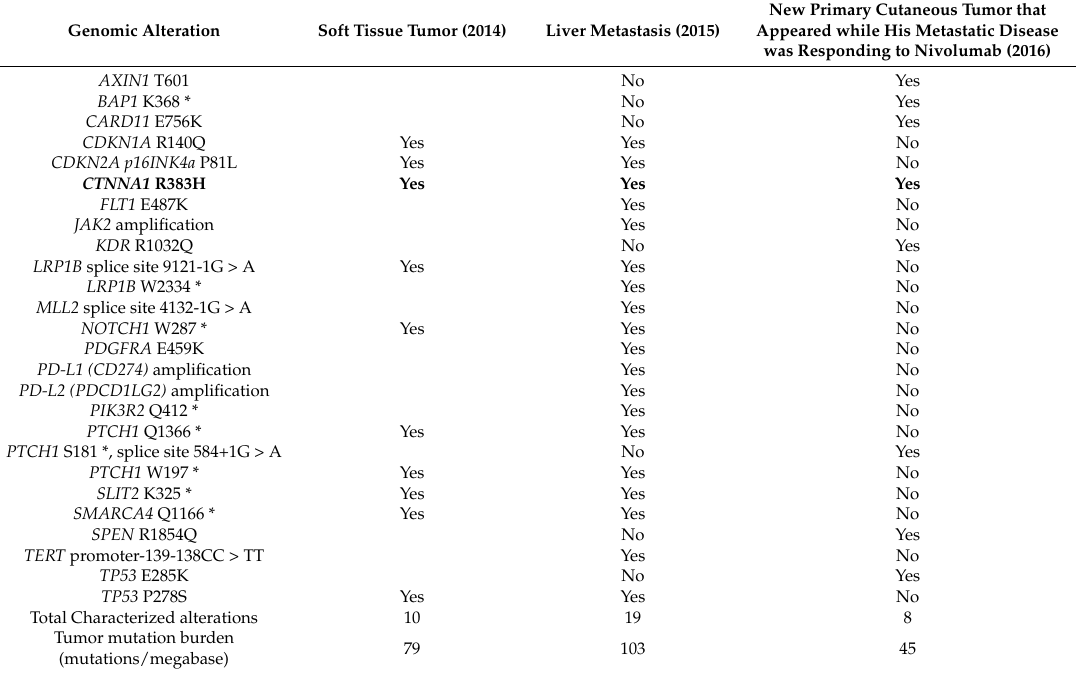
Table 1. Genomic aberrations of patient’s basal cell carcinomas.